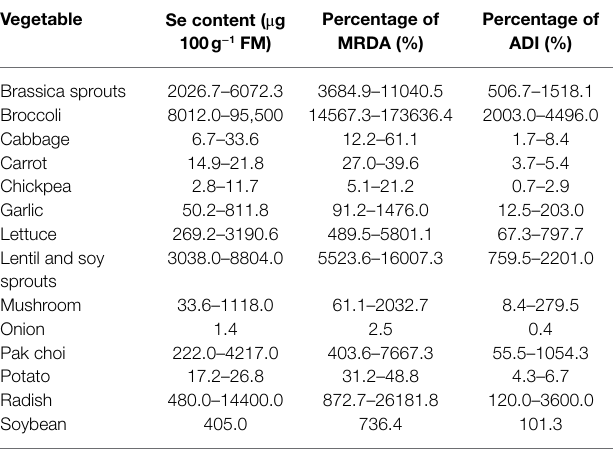
TABLE 2 | Calculated percentage of minimum recommended daily allowance and acceptable daily intake for selenium-enriched vegetables and mushrooms.